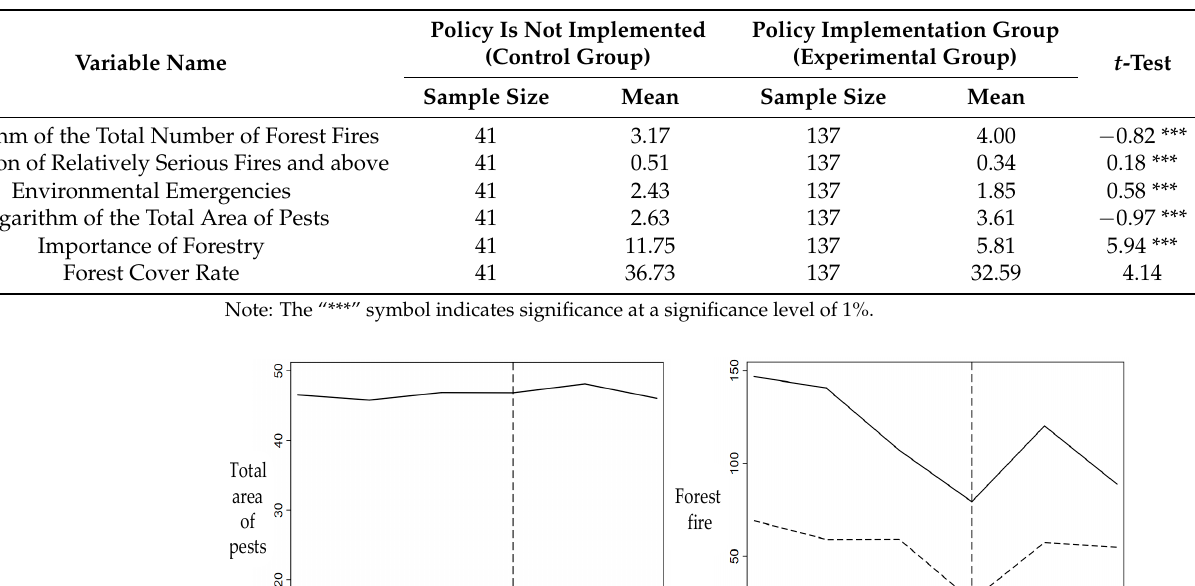
Table 4. Differences in the protection of forest resources between the experimental group and control group.